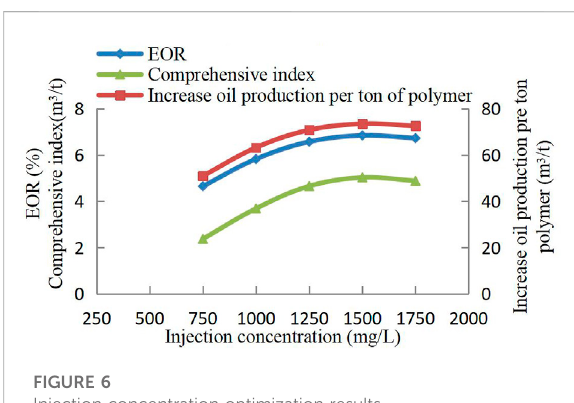
FIGURE 6 Injection concentration optimization results.